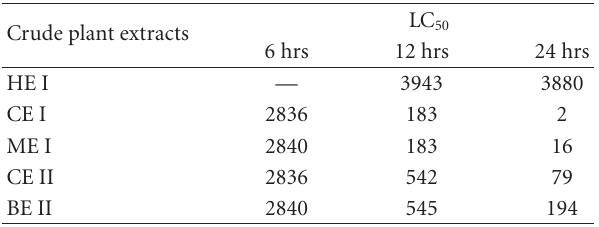
Table 4: The LC 50 values of Percentage lethality of Artemia salina ( μ g/mL).